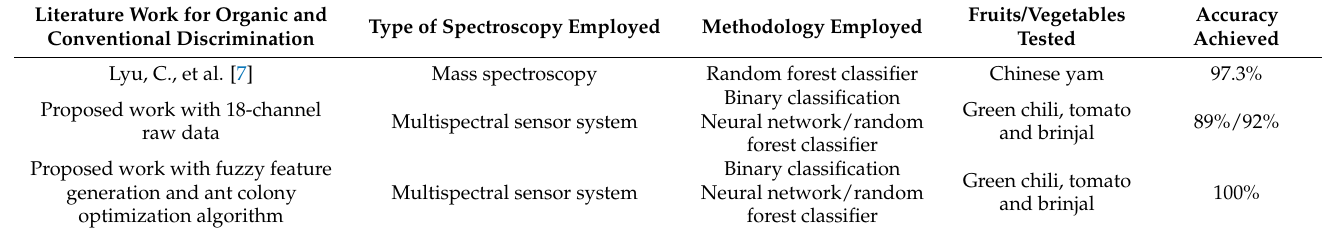
Figure 12. Receiver operating curve. Table 8. Performance